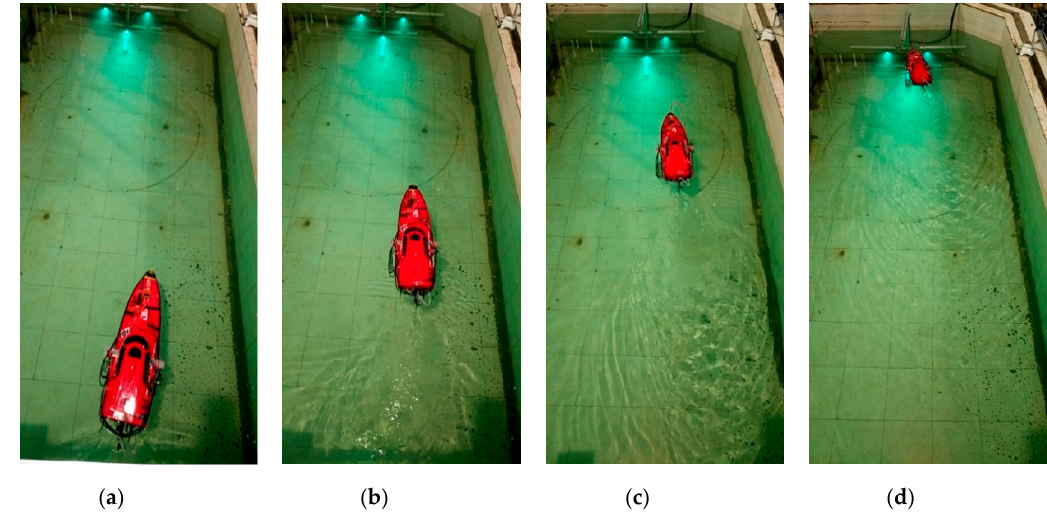
Figure 18. Several photographs acquired during the docking process when the ship model starts at the right side of the docking station: The ship model ( a ) sets off from the initial position on the right; ( b ) turns left to the target; ( c ) moves towards it; ( d ) achieves the docking station successfully.